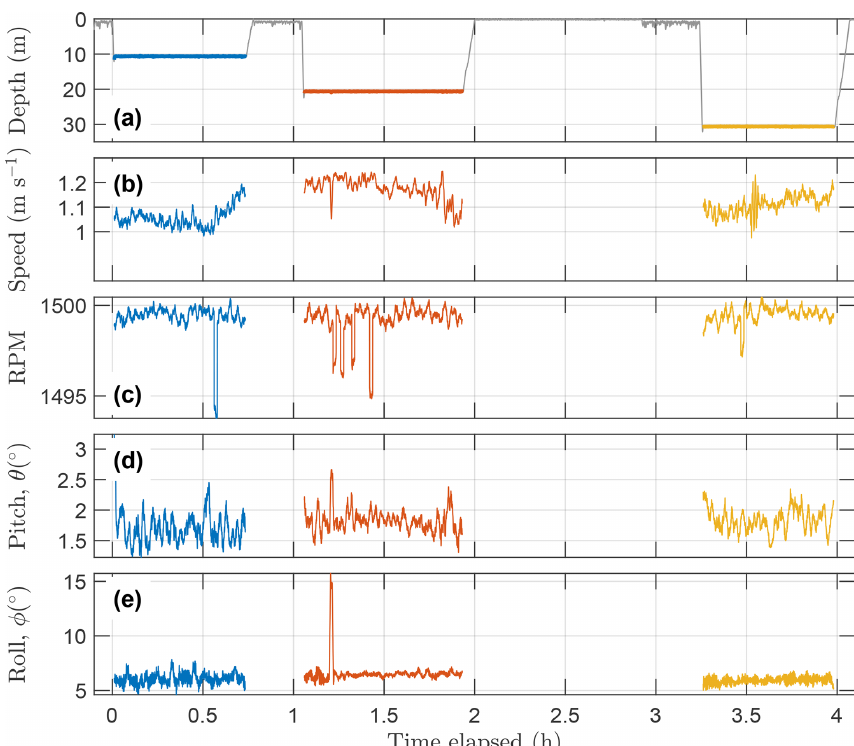
Figure 4. Flight kinematics from the AUV. Time series of (a) depth, (b) speed past the instrument, (c) rotation per minute (RPM), (d) pitch and (e) roll. Time elapsed is from 26 February at 08:06UTC. Selected transects at approximately 10, 20 and 30m are